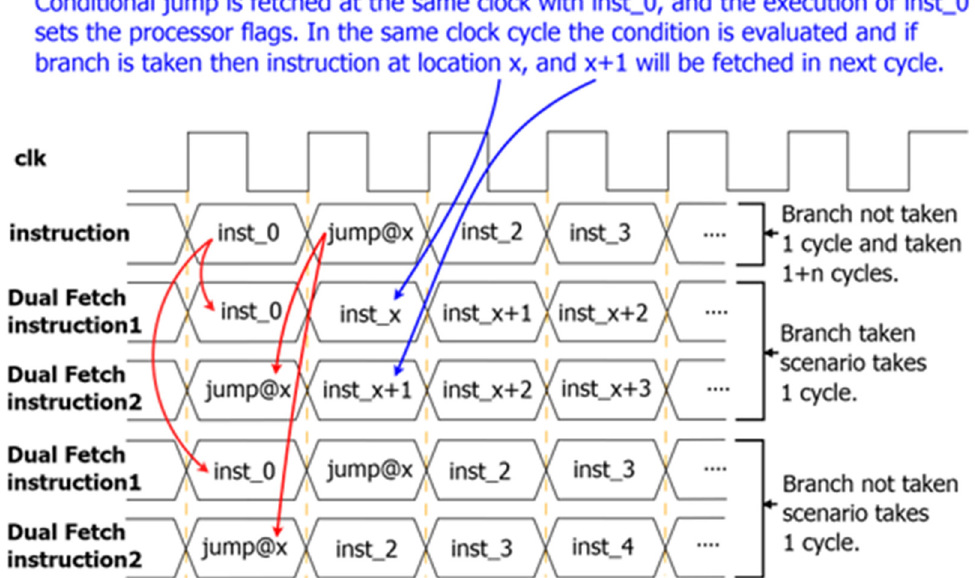
Figure 6. Description of the dual-fetch mechanism and how it allows conditional branch instructions to take one clock cycle, regardless of them being taken or not